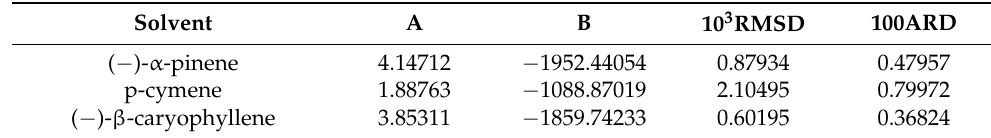
Table 9. Regression results and model parameters of the van’t Hoff model of dehydroabietic acid in solvents.